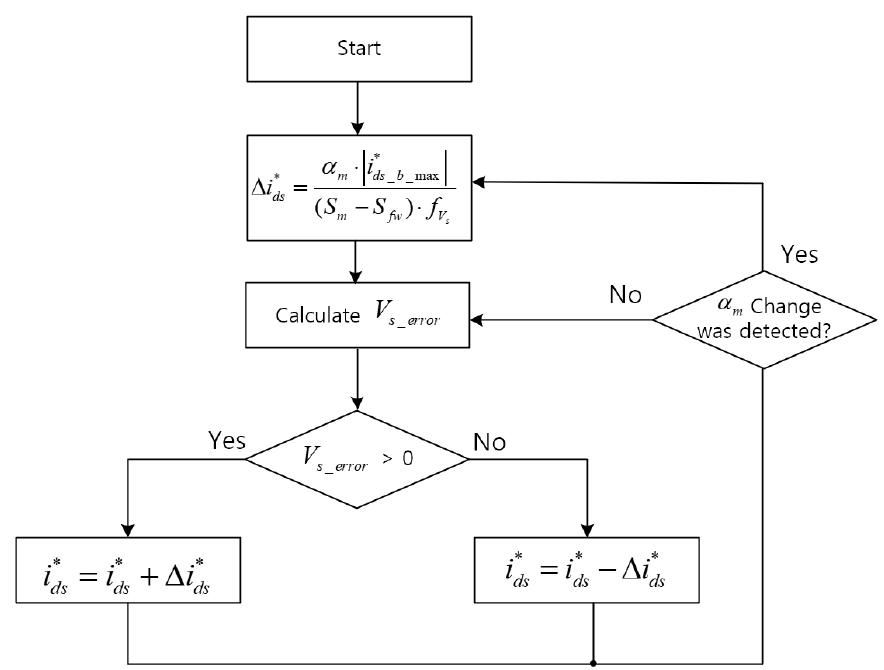
Figure 3. Algorithm flowchart of the proposed variable incremental controller.